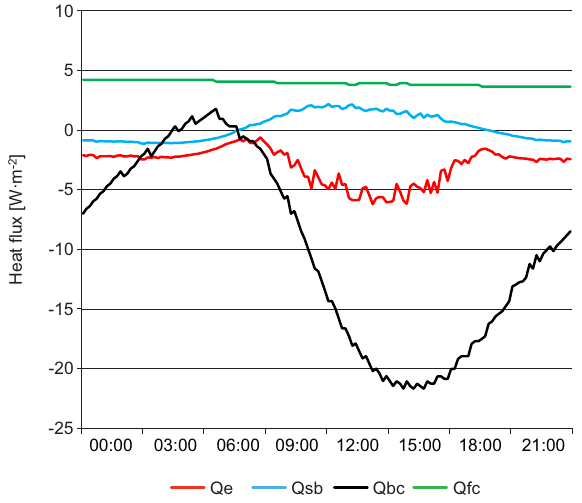
Fig. 4. Non-radiative components of the energy budget dur- ing summer day – 4 July 2013 (see explanations in text)